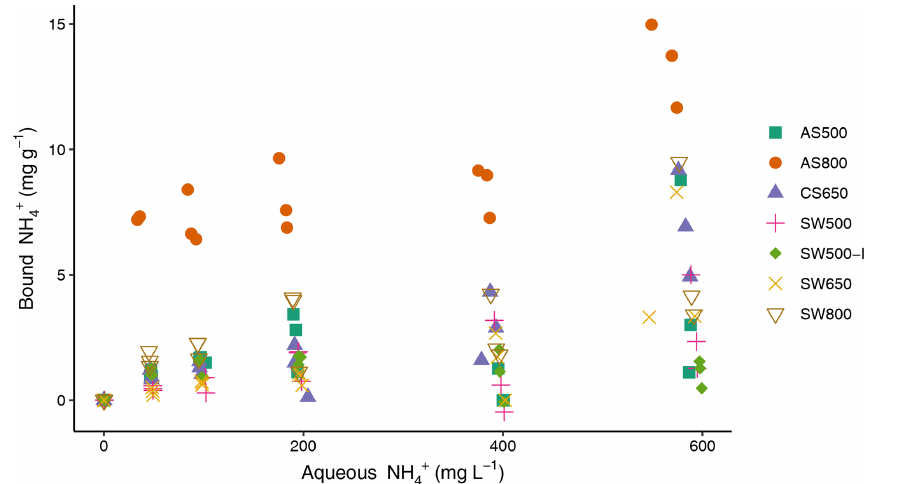
Figure 2. Sorption isotherms for ammonium and biochars, performed in triplicate at 22 ± 1 ◦ C. All solutions were prepared in 0.1mMNaCl and spiked at 1% volume with a stock solution of 20gL − 1 sodium azide to inhibit microbial growth.